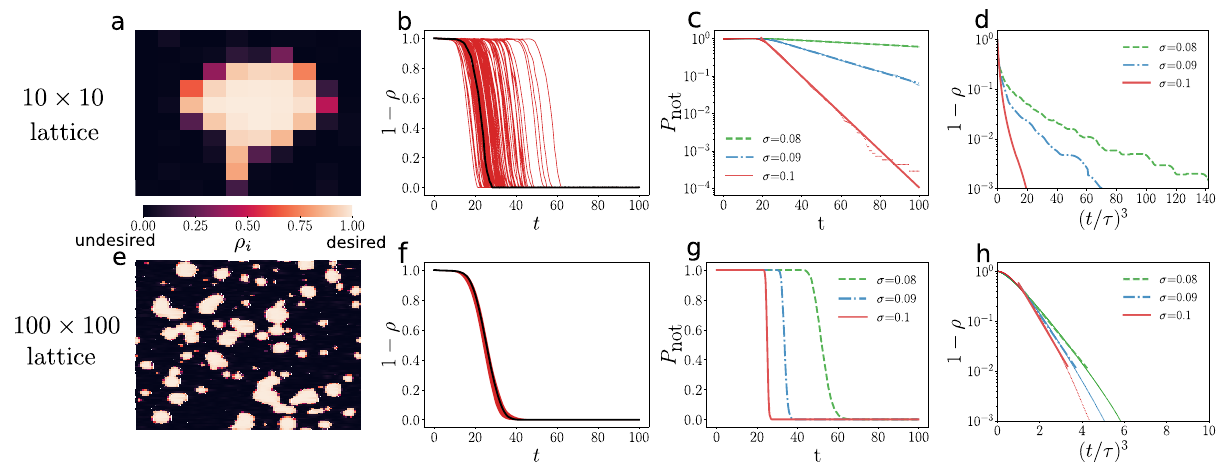
Fig. 2 Single-cluster and multi-cluster modes in the mutualistic system. a One snapshot for the state value ρ i of each node under the noise strength σ = 0.1 ( σ is de fi ned by the standard deviation of noise distribution). The color scale is used to represent the values of normalized state ρ i (de fi ned in Eq. (2), and it is unitless) from the undesired state ( ρ i = 0) to the desired state ( ρ i = 1). Initially, all of the nodes are at the low state. At some time later, the transition to the high state occurs to one node, which is treated as a single cluster. Such transition then spreads out to its neighbors. b The evolution of the global state ρ for 100 realizations of the single-cluster mode. c The probability distribution of waiting time P not for the fi xed system size and various noise strengths σ = 0.08, 0.09, 0.1. The single dots are simulation data, and different types of lines are obtained by linear fi t according to Eq. (8). d The evolution of the average global state ρ using the same data as in c . e One snapshot shows the state ρ i of each node for σ = 0.1. Different from a , the transition from the initial low state to the high state occurs at several separate nodes, and they expand independently, forming the multiple cluster. f The evolution of the global state ρ for 100 realizations, which are more centered around a certain value instead of being random in b . g The distribution P not for σ = 0.08, 0.09, 0.1, which approaches the step function as σ increases. h The evolution of the global state ρ averaged over 100 realizations using the same data as in g . The single dots are simulation data, and different types of lines are obtained by linear fi t according to Eq. (9).